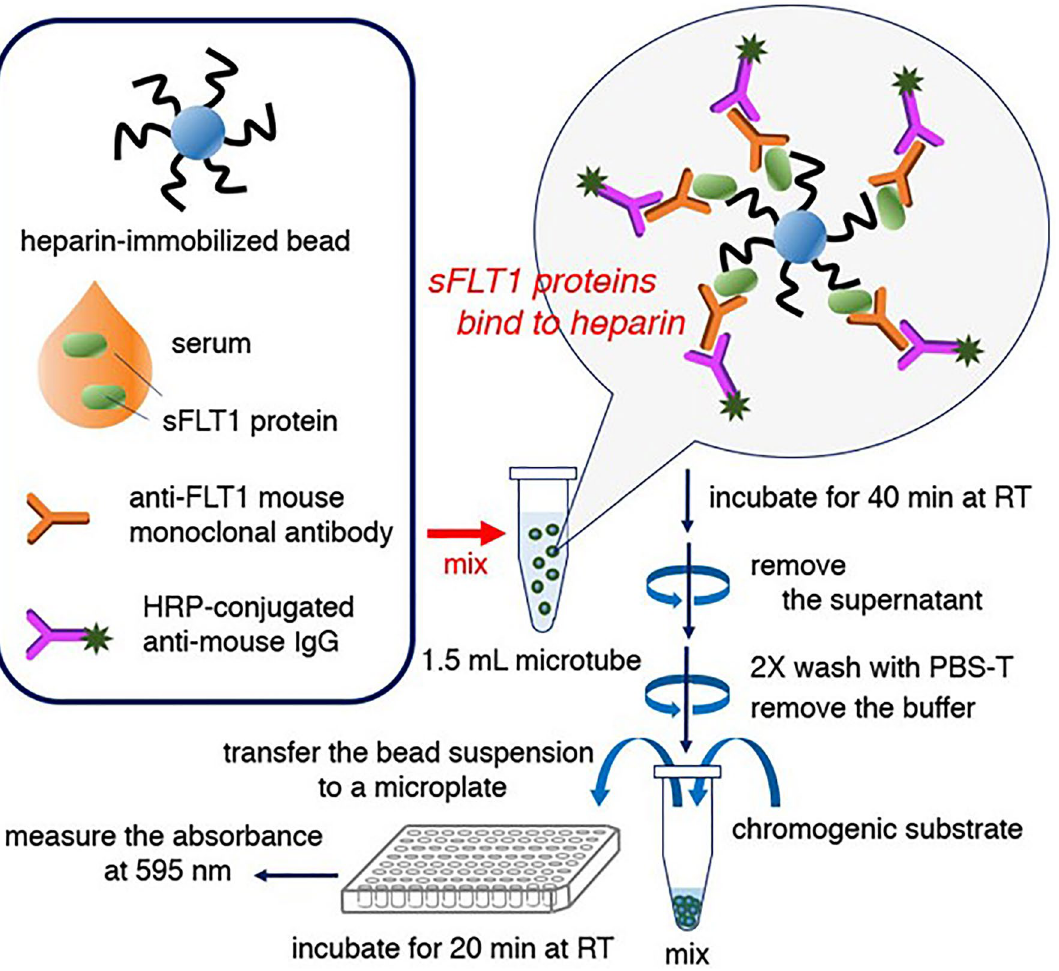
Figure 1. Schematic model for the new ELISA, heparin-beads-coupled ELISA